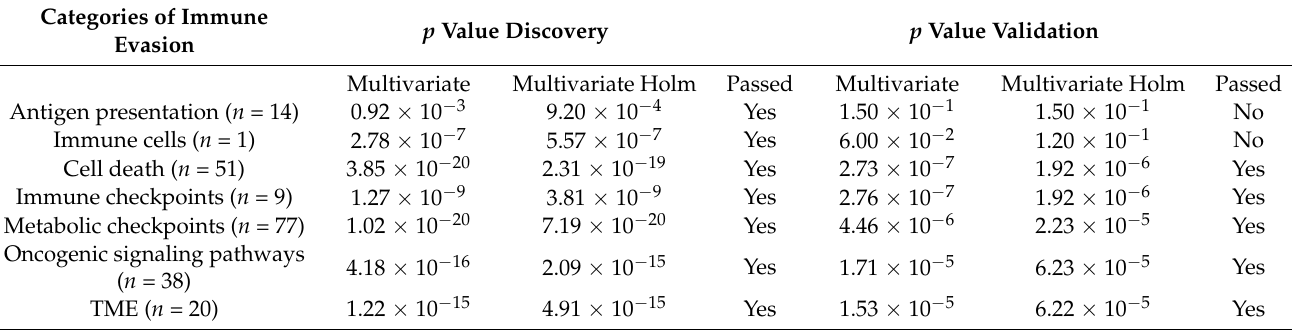
Table 2. Ridge regression analysis for OS per list of immune-evasive genes.